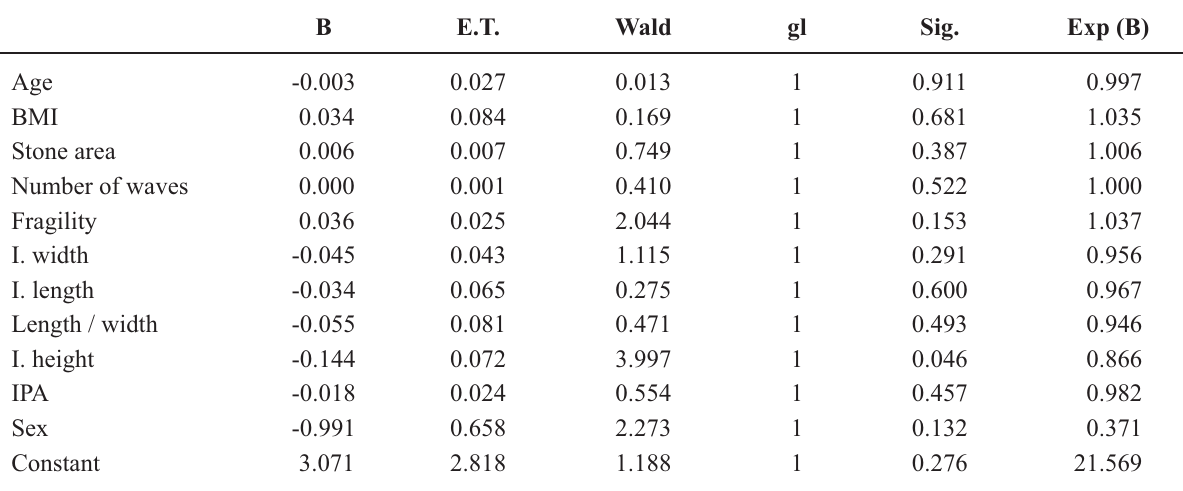
Table 2 – Logistic regression analysis. B E.T. Wald